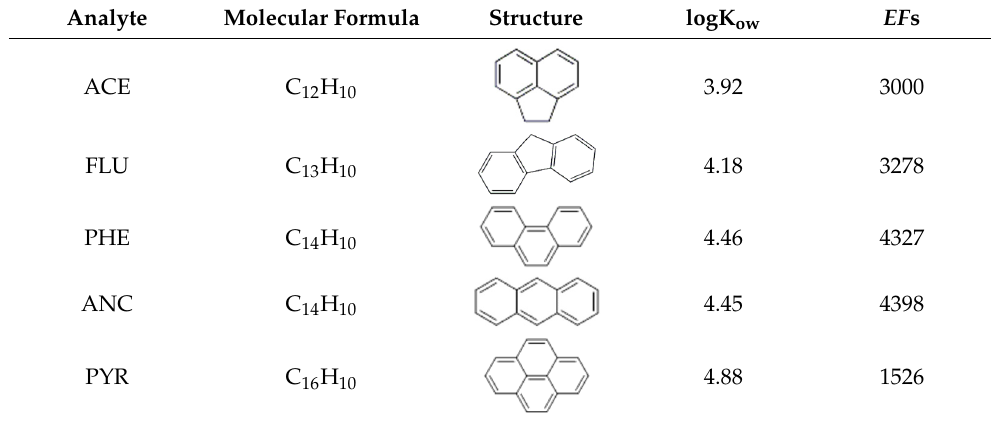
Table 2. The molecular formula, structure, logK ow and EF s that obtained with the developed method. Analyte